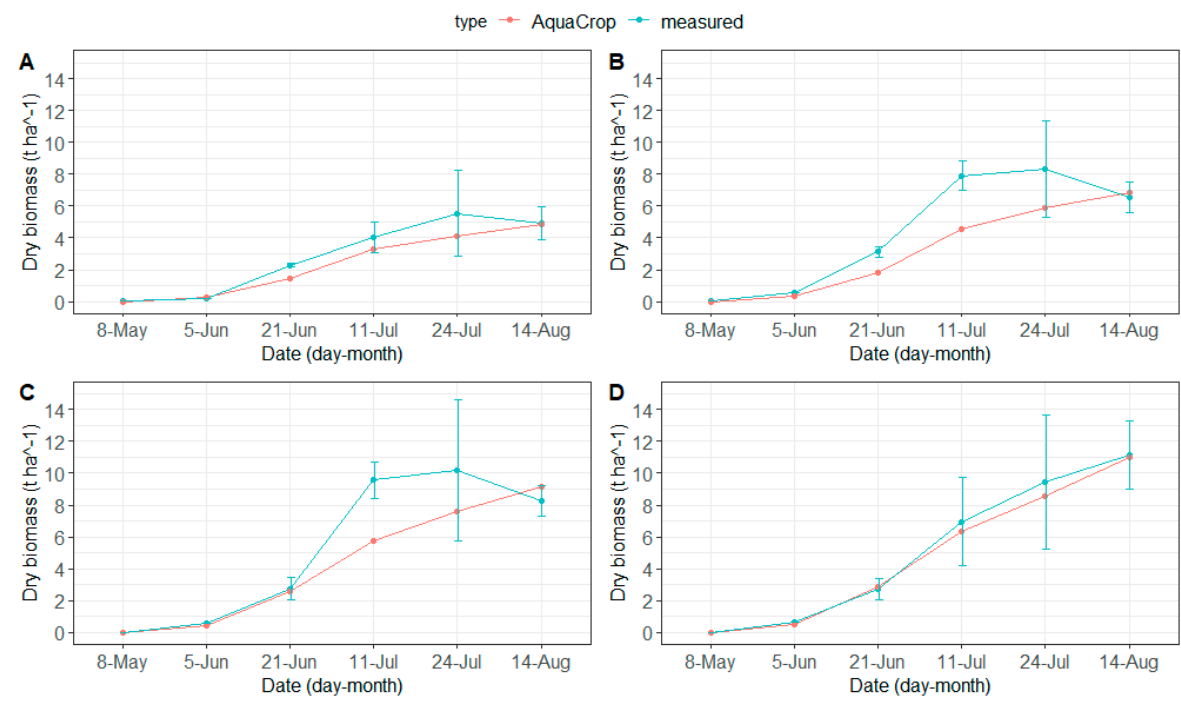
Figure 1. Simulated and measured biomass values for the 2018 growing season (calibration). Error bars represent the standard deviation (n = 4). The ( A – D ) letters refer to the K, I50, I75, and I100 treatments, respectively.